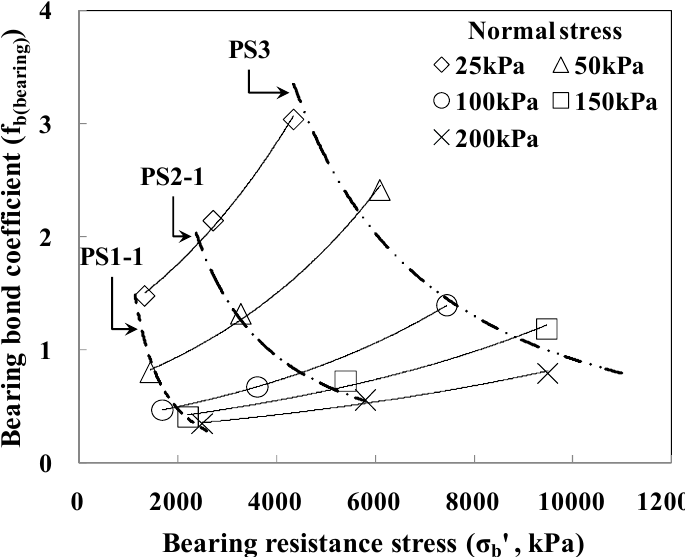
Figure 9. Relationship between bearing-resistance stress and bearing bond coefficient. If normal stress is higher than a certain level, bearing-resistance stress has a high value, but a number of transverse members have little effect on the bearing bond